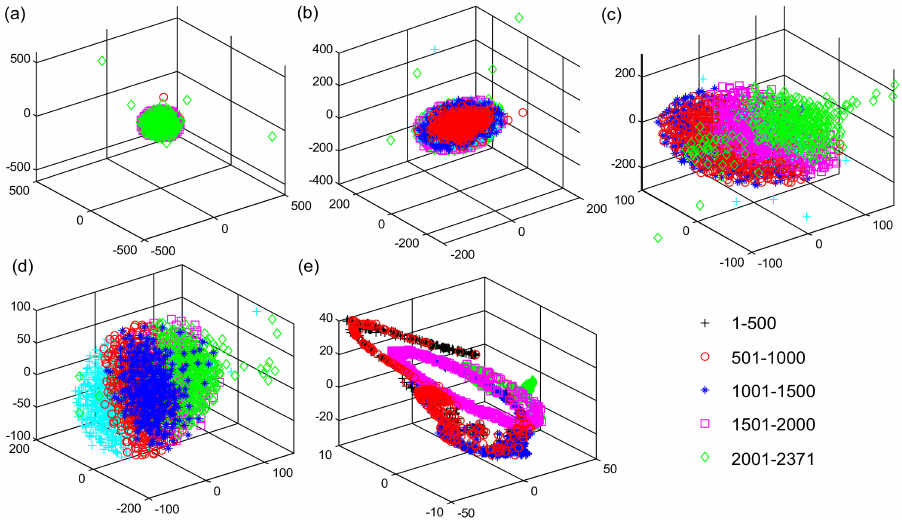
Figure 16. Visualization results of the different layers for the CNN. ( a ) Network input; ( b ) First Convolution layer; ( c ) Second Convolution layer; ( d ) Third Convolution layer ( e ) FC2 layer.